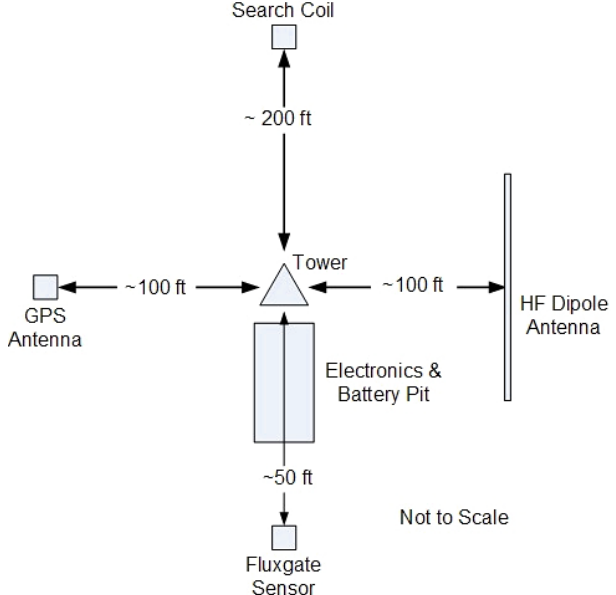
Figure 1. Schematic diagram of the site plan for the deployment of an AAL-PIP system supporting fluxgate magnetometer, search coil (or induction) magnetometer, CASES dual-frequency GPS receiver and HF transceiver